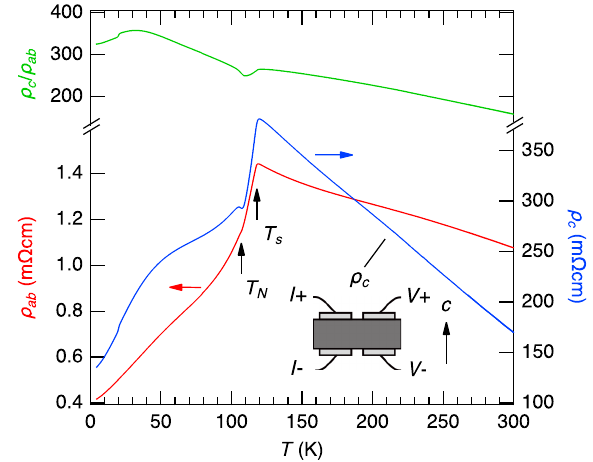
FIG. 2. Temperature dependence of resistivity in CaFeAsF. The c -axis and ab -plane resistivities were measured using two different samples. The inset explains the contact configuration for the c -axis measurements. The upper panel shows the = ρ anisotropy ρ c ab